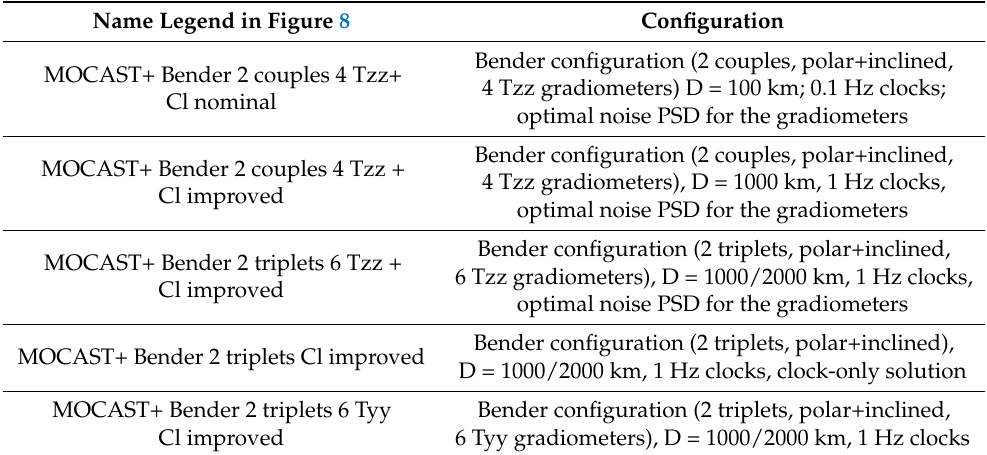
Table 2. Mission configurations simulated in the frame of the MOCAST+ project. D = distance between couples or triplets of